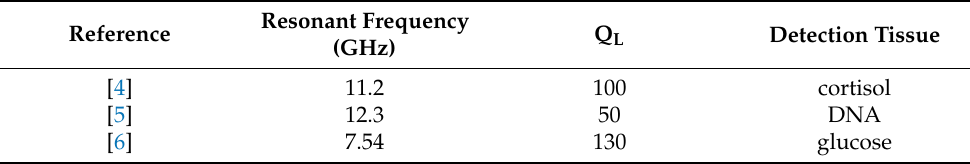
Table 1. Resonator Q L for tissue marker